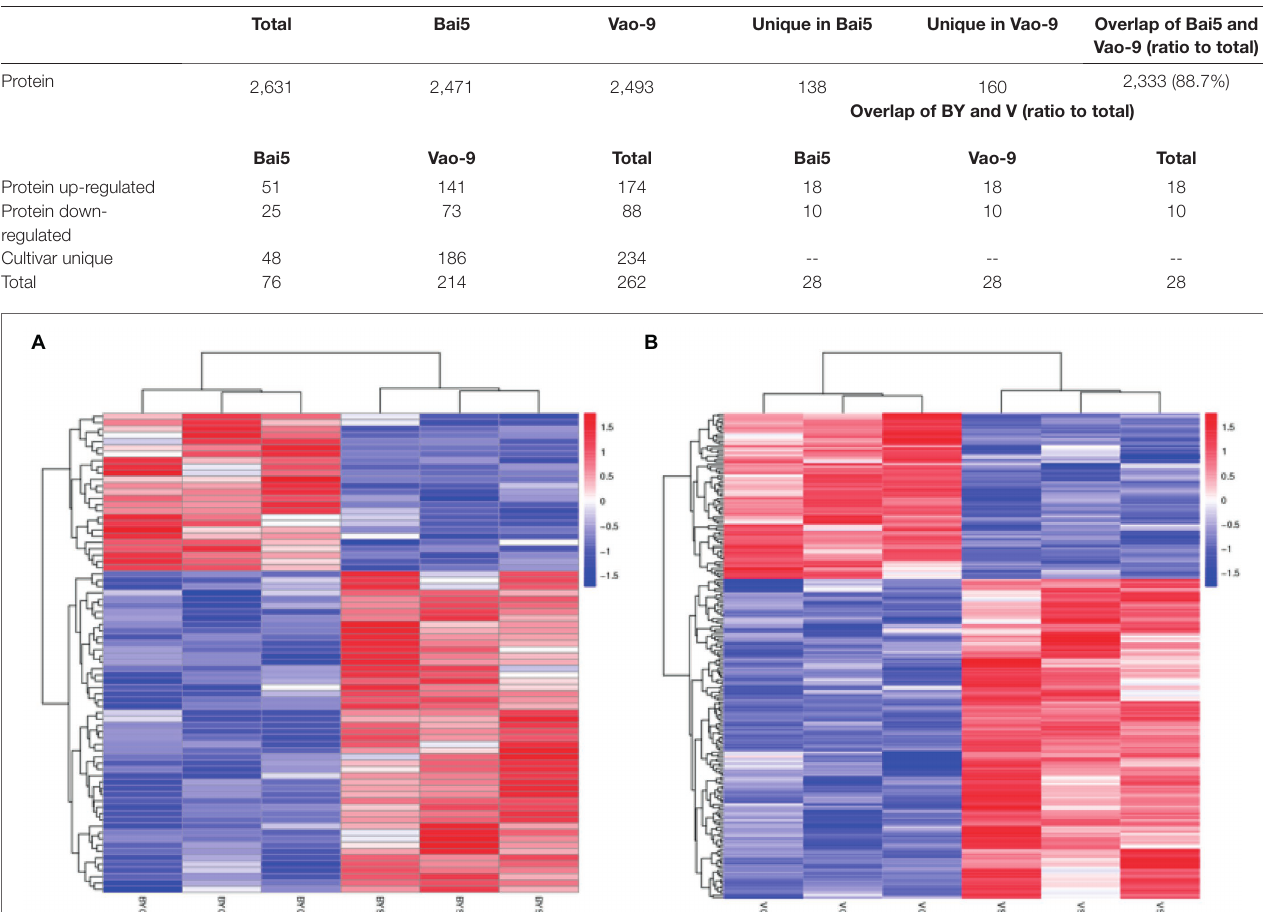
TABLE 2 | Number of proteins and DEPs identified from the samples (>2 or <0.65-fold change, p < 0.05).